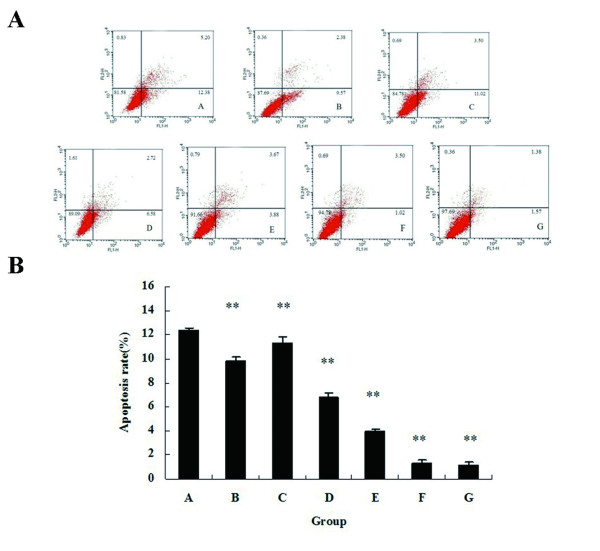
Analysis of PC-3 cells apoptosis. A. Flow cytometric detection of PC-3 cell apoptosis. The points of lower right quadrant represent apoptotic cells, and the points of upper right quadrant are on behalf of necrotic cells. The apoptosis rate of Group A was 12.38%, which was higher than those of the other groups. B. The average apoptosis rates of all 7 groups are shown in the bar chart. Higher percentage of apoptosis cells were detected by Annexin V-FITC and PI staining in Group A than in other groups. ** indicates P < 0.01 when compared to Group A.